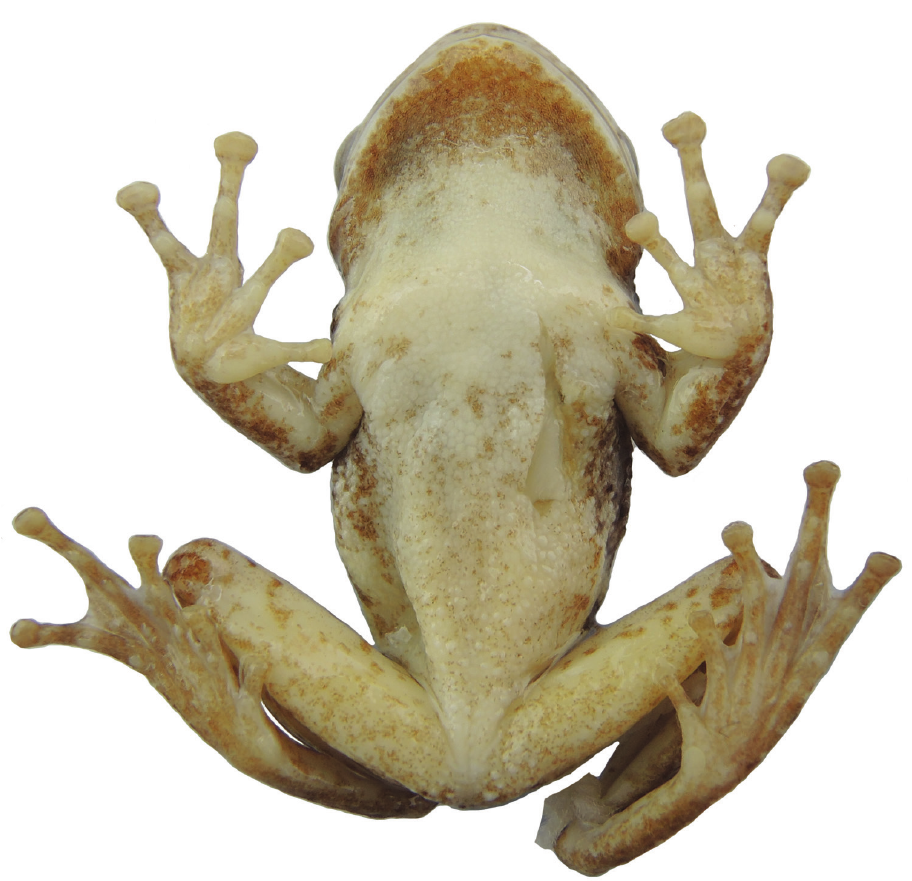
Figure 7. Ventral view of paratype KIZ